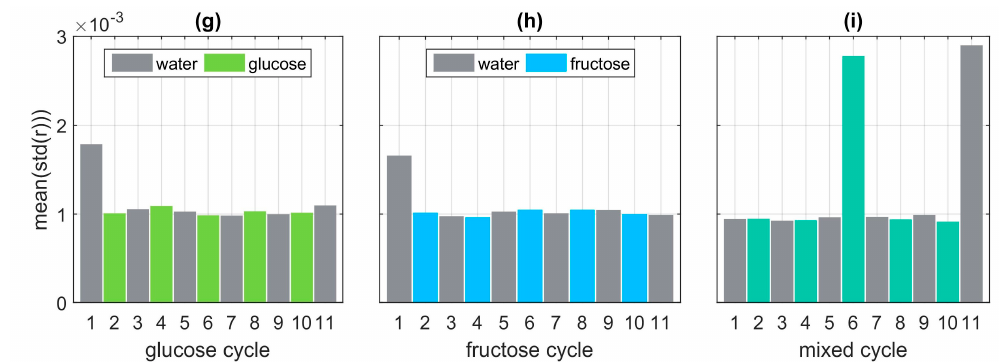
Figure A2. Statistical analysis of the measurement sets for each of the three cycles. The glucose/fructose concentration for each set is depicted in panels ( a–c ). The corresponding mean value of the variance within the fingerprint region ranging from 1000 – 1100 cm − 1 (compare to panel (d) of Figure A1) is visualized in panels ( d–f ). The corresponding mean value of the standard deviation is depicted in panels ( g–i ).